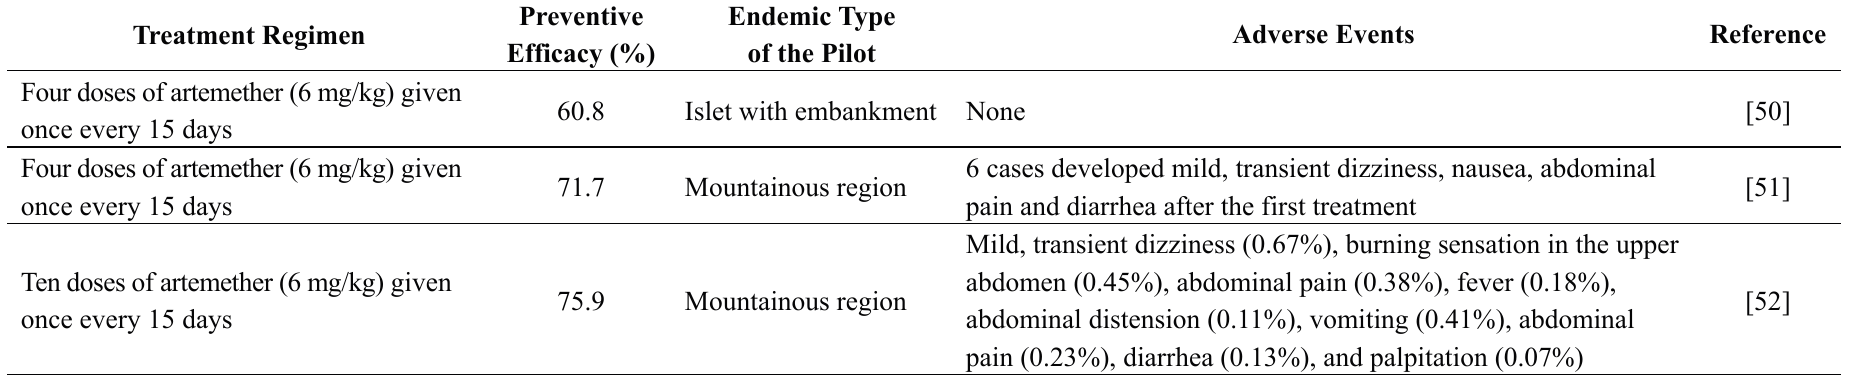
Table 1. Clinical trials reported to test the preventive efficacy of artemether against S. japonicum